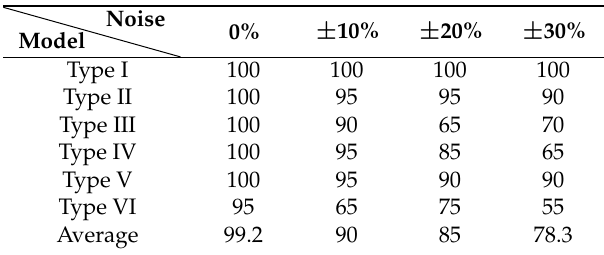
Figure 14. Feature distributions for time-frequency-energy 3D spectrums by IHHT with the z axis representing the discharged energy level. Table 3. Identification results by IHHT versus features FD ‐Λ‐ MD ‐ E.